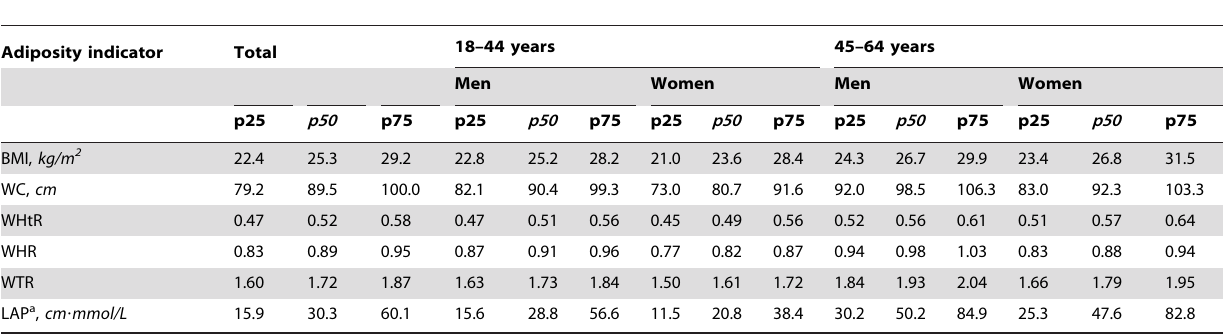
Table 2. Median ( p50 ) and interquartile boundary values (p25, p75) for baseline adiposity indicators by age group and sex among U.S. adults, 1988–1994.